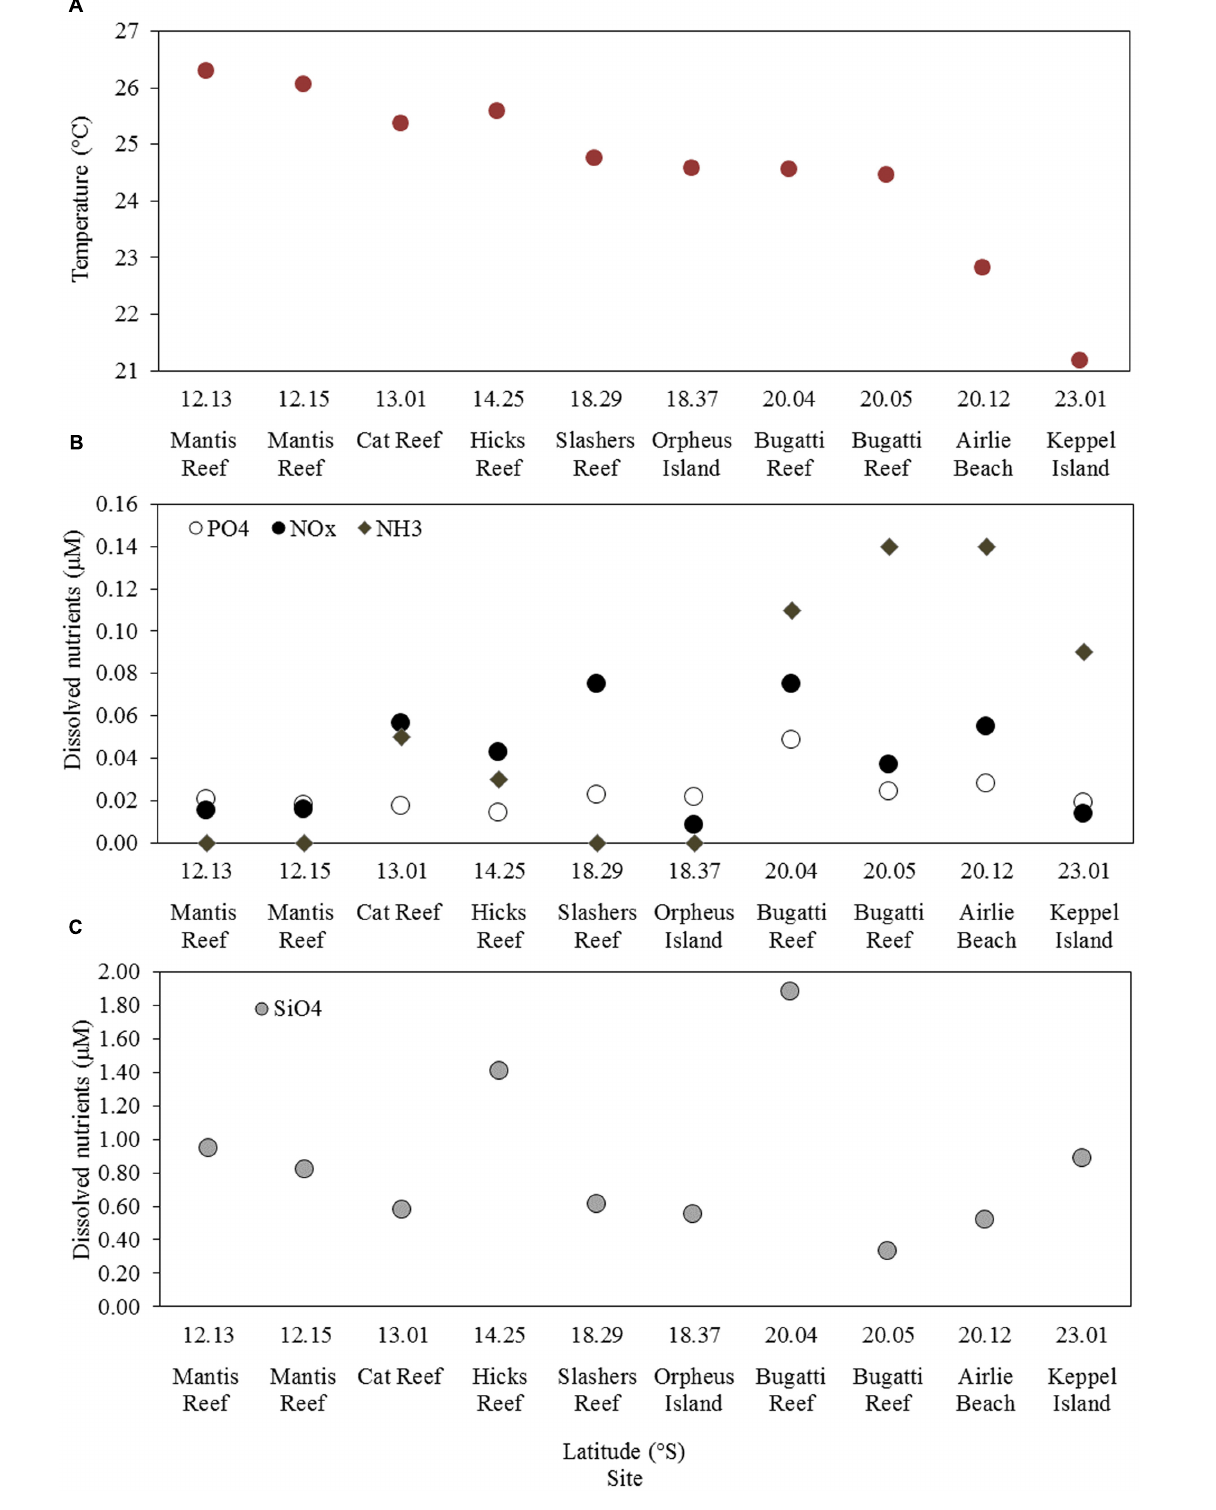
FIGURE 2 | Environmental characteristics of each study site including: (A) sea surface temperature (SST), (B) concentrations of NH 3 , PO 4 and NOx, (C) concentrations of SiO 4